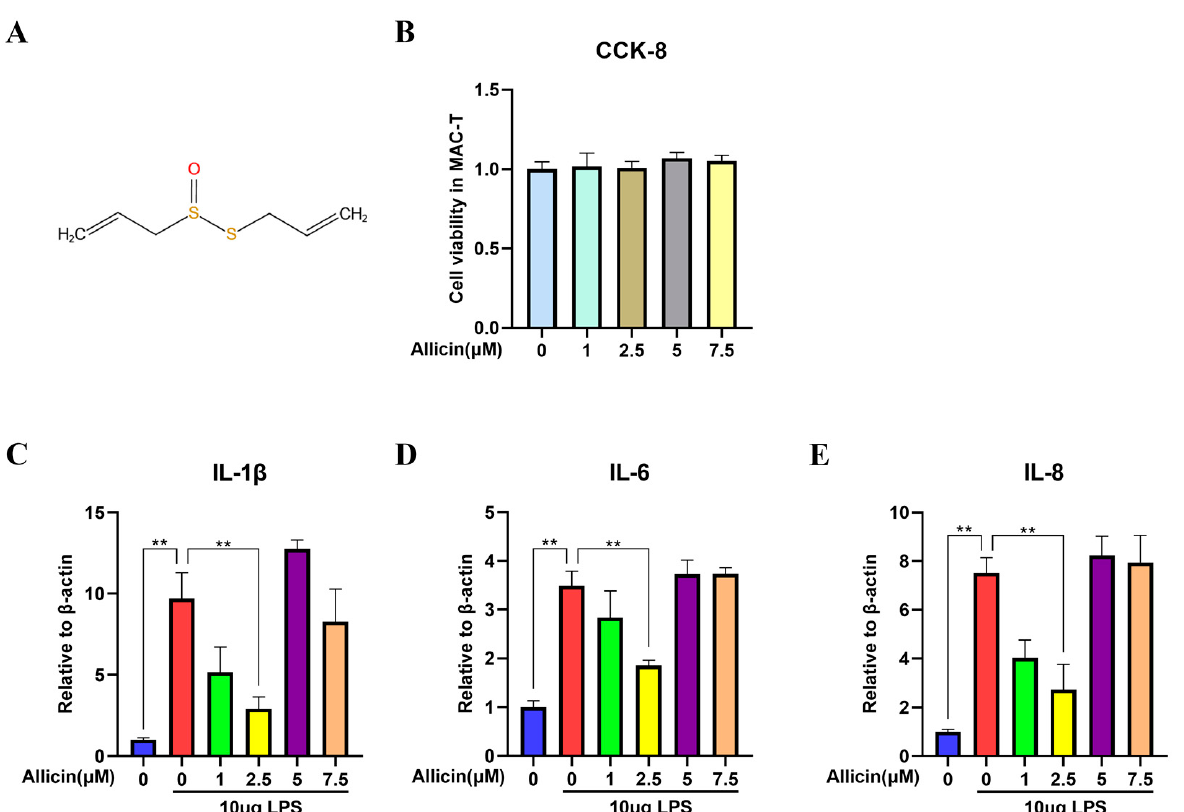
Figure 1. Effect of allicin on MAC-T cell viability and inflammatory cytokine levels in cells. ( A ) The structural formula of allicin. ( B ) Effect of allicin on cell viability. MAC-T cells were incubated with different concentrations of allicin (0, 1, 2.5, 5, and 7.5 µM) for 24 h. Cell viability was measured using the CCK-8 assay. ( C – E ) Effect of allicin on the expression levels of inflammatory cytokines in cells. The mRNA expression levels of IL-1 β , IL-6, and IL-8 in MAC-T cells were measured using RT–qPCR with β -actin used as an endogenous control; **, p < 0.01.